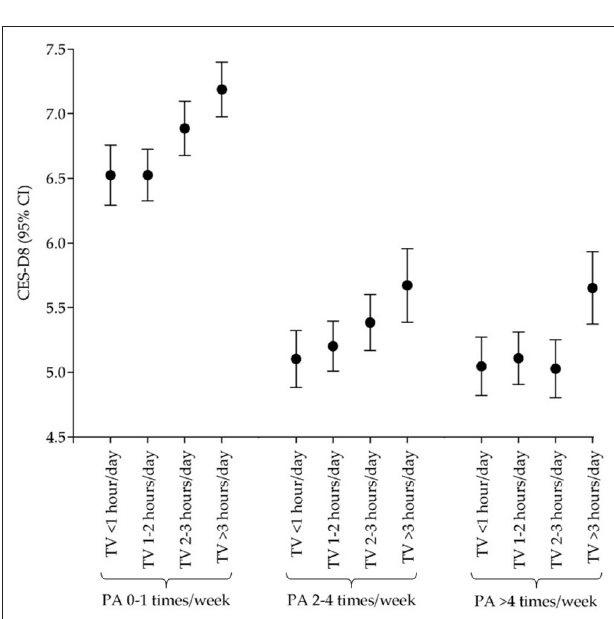
FIGURE 2 | Relationship across physical activity, TV watching, and depressive symptoms in women.